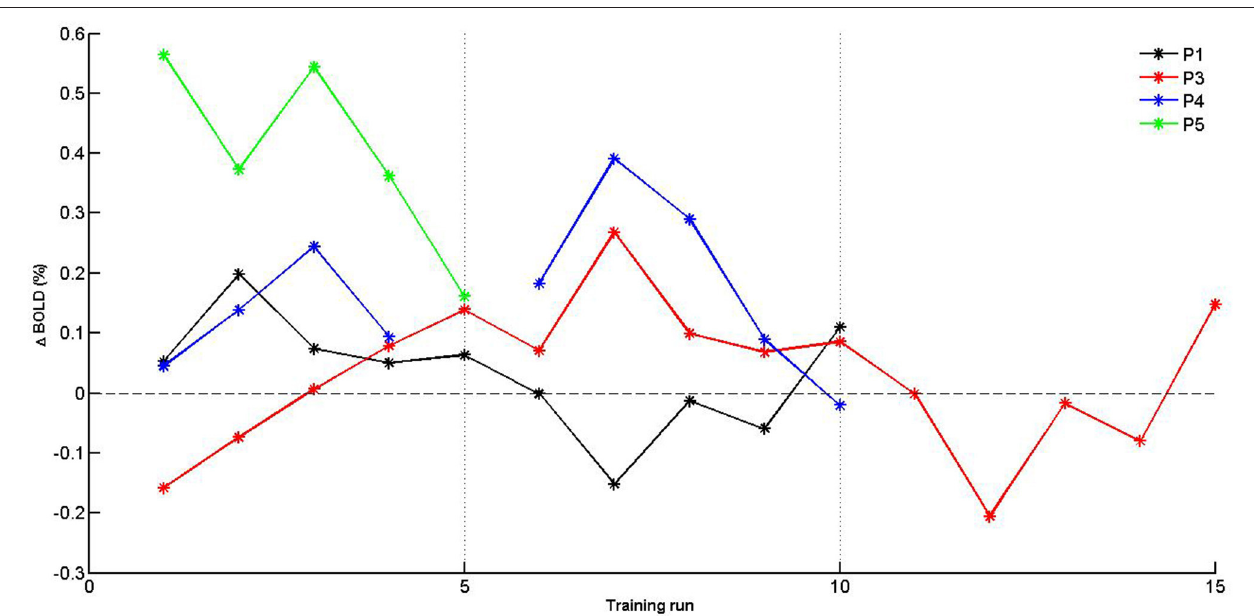
FIGURE 5 | Individual PSC ( 1 BOLD) values of supplementary motor area (SMA) activation for training runs. Separate training sessions indicated by dotted vertical lines.